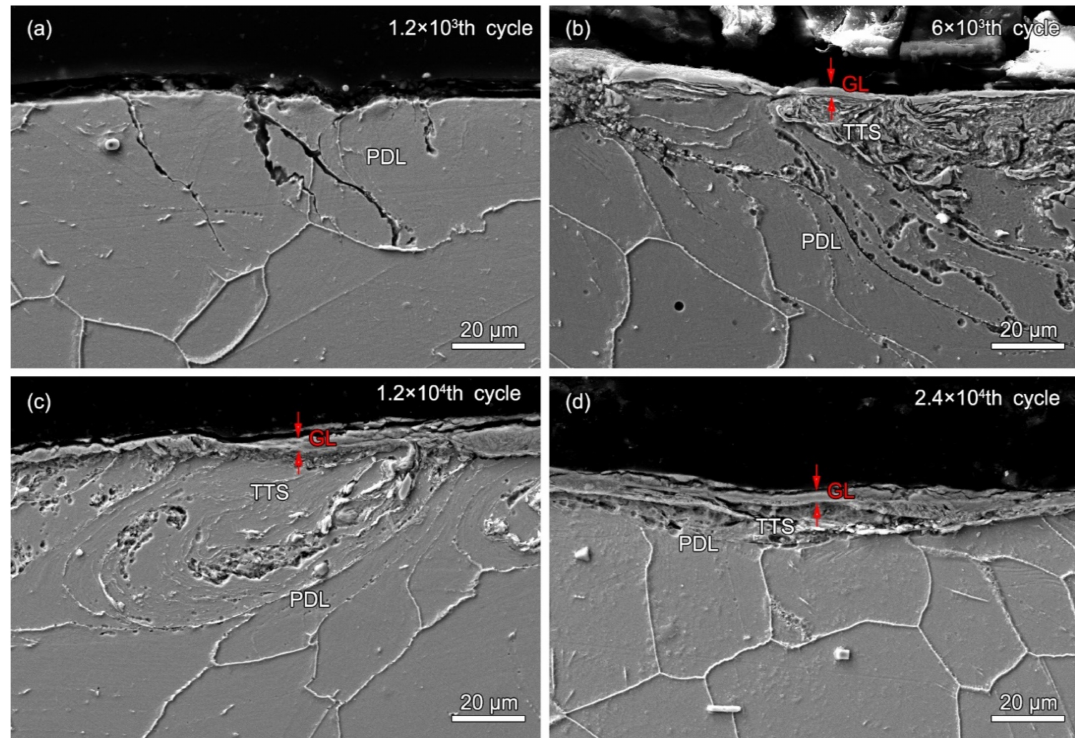
Figure 8. The local cross-sectional SEM images of the wear scars of alloy 690TT after fretting cycles